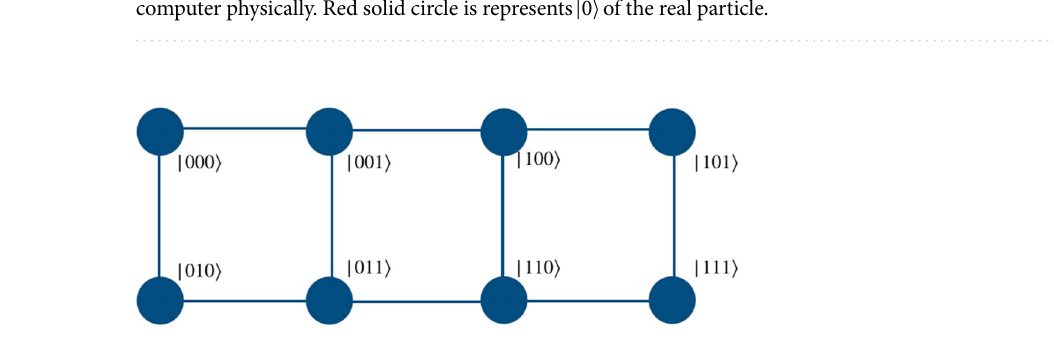
Figure 13. Illustration of an extension of position space mapping of three-qubit system to four-qubit system by connecting two three-qubit models position state by two edges. This is one of the many ways to multiply qubits for quantum walk based computational scheme.